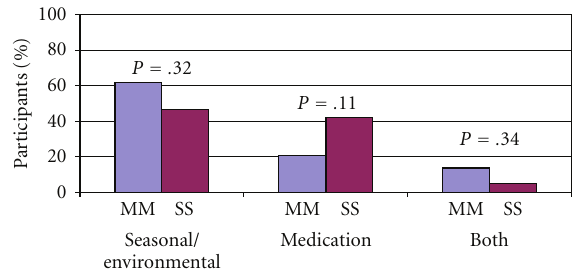
Figure 1: Percentage of seasonal/environmental allergies, medi- cation allergies, or both seasonal/environmental and medication allergies in the study cohort ( N = 19) compared to the controls ( N = 29).